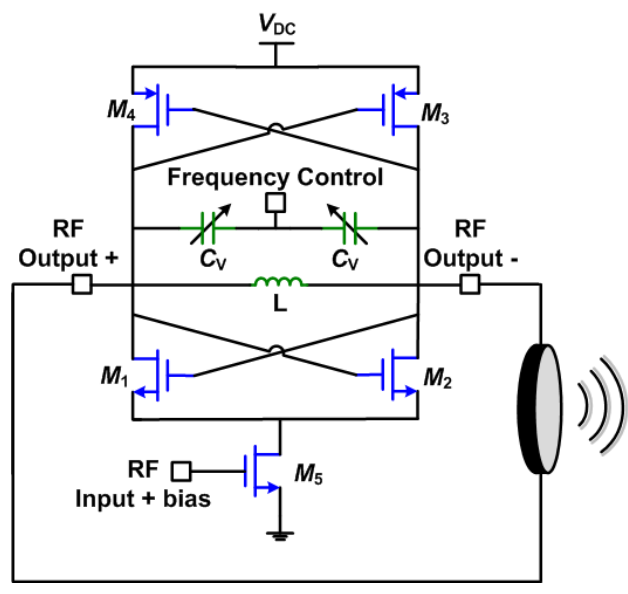
Figure 15. Basic schematic of the lock-mode power amplifier